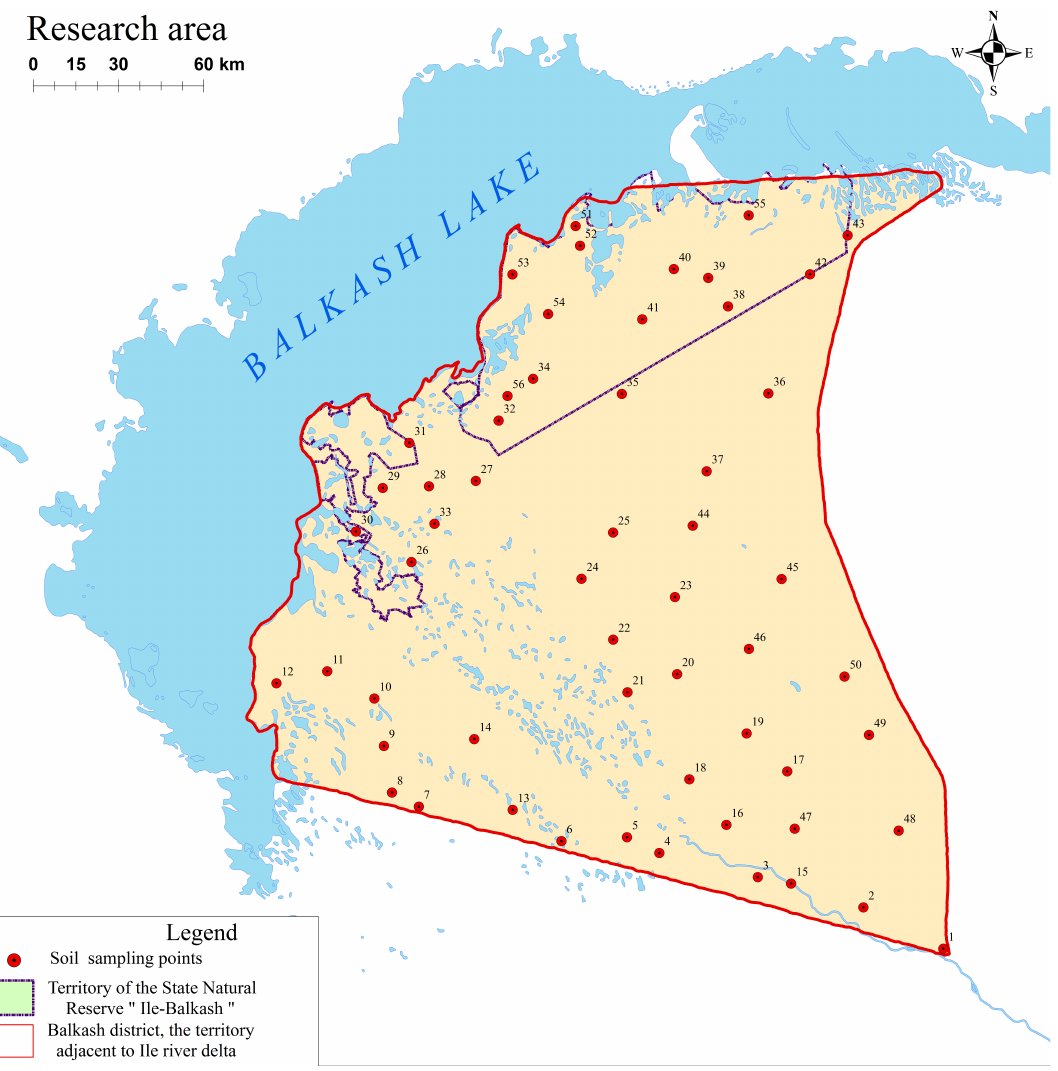
Figure 2. Location of the study areas. Figure 8. Delta of Ili River and the territory of “Ili-Balkhash Lake” reserve (authors Madibekov A.S., Zhadi